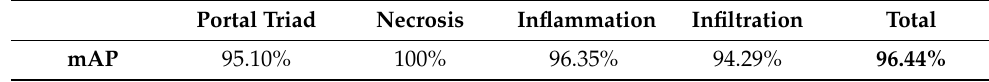
Table 2. Mean average precision (mAP) in Mask R-CNN training. Portal